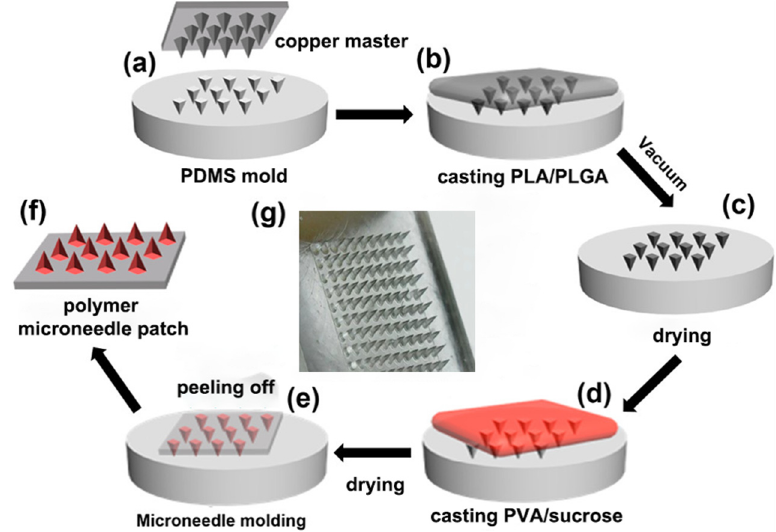
Figure 2. Schematic of the fabrication process of drug-loaded MN-patches: ( a ) replication of PDMS negative molds by casting the prepolymer onto a copper master; ( b ) casting PLA/PLGA onto the PDMS molds with microcavities; ( c ) fabrication of PDMS mold by vacuum; ( d ) casting PVA/sucrose prepolymer onto the PDMS mold; ( e ) drying the mold; ( f ) peeling off the polymer microneedle patch from the PDMS mold; ( g ) the physical picture of the microneedle by electronic magnifier.